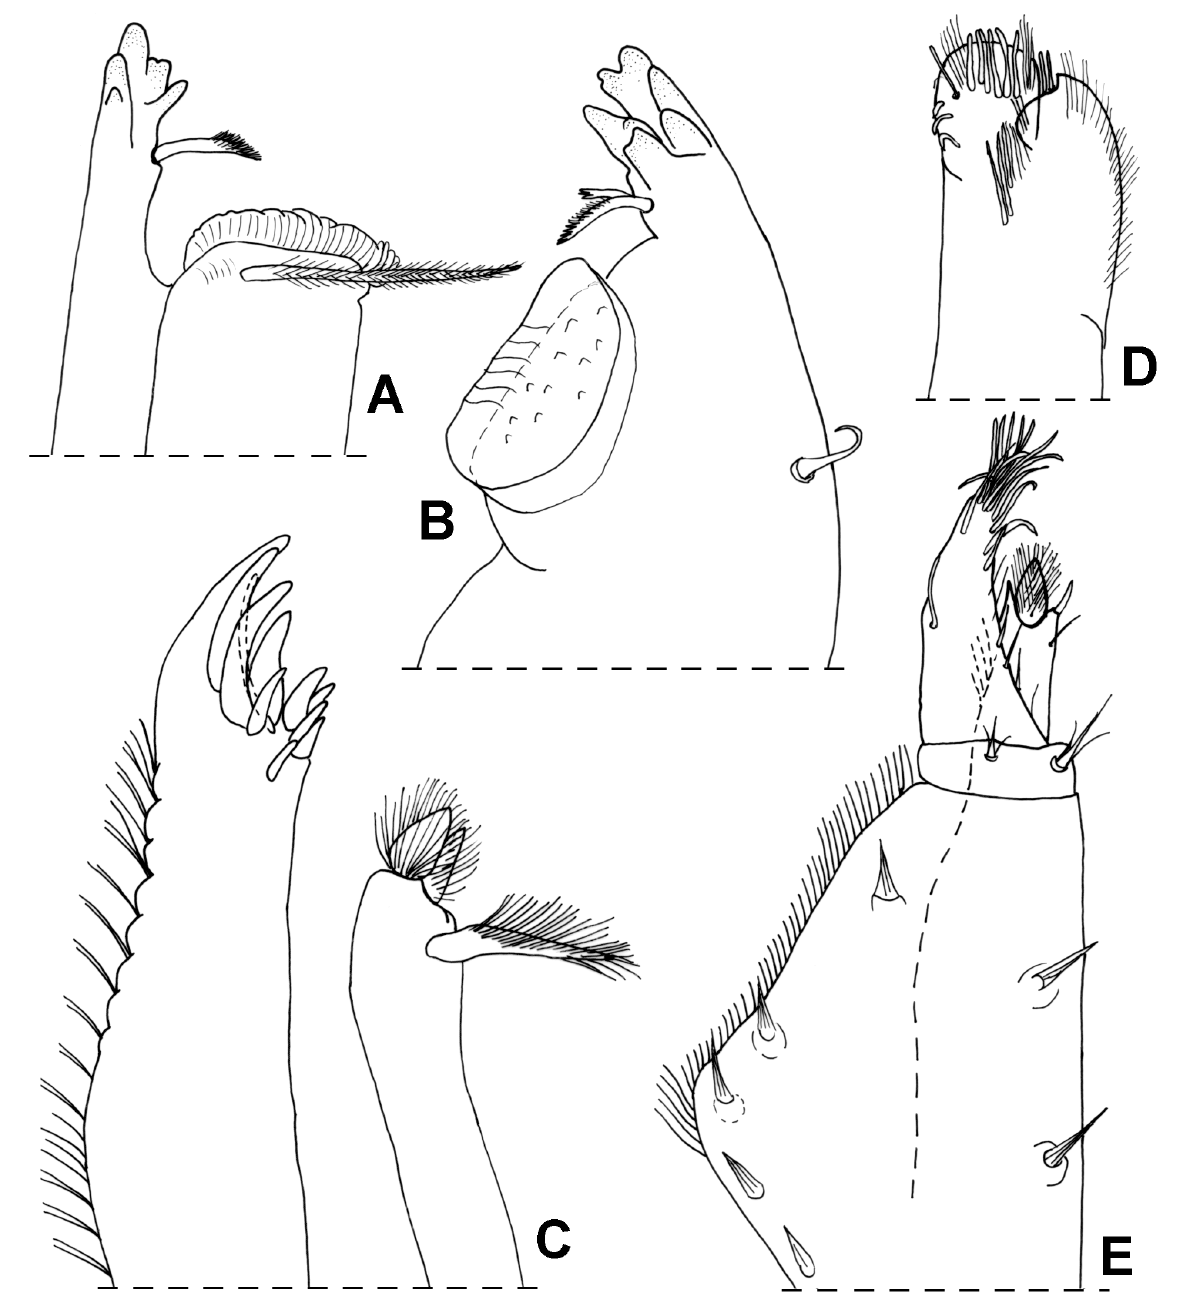
Fig. 24. Cordioniscus lusitanicus Reboleira & Taiti sp. nov. from Algar de Santo António, Estremoz- Cano, paratype, ♀. A . Right mandible. B . Left mandible. C . Maxillula. D . Maxilla. E .